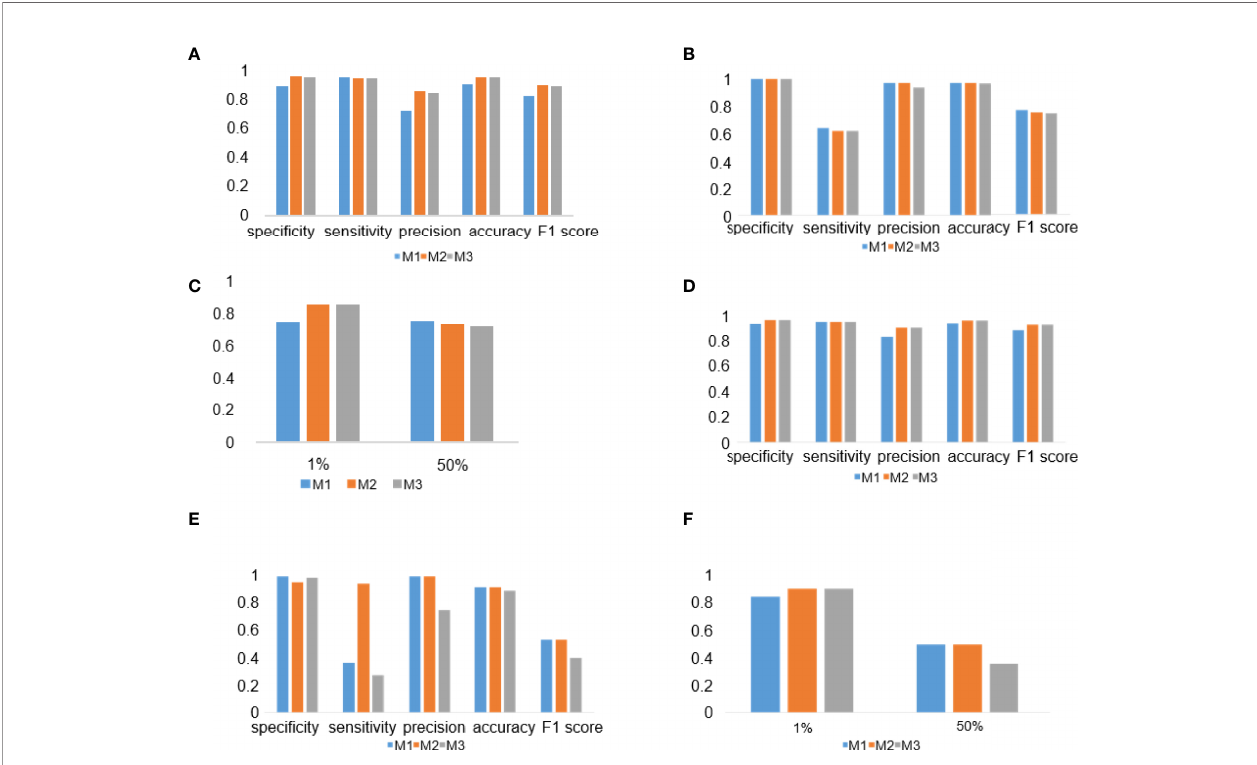
FIGURE 4 | Deep learning (DL) model performance evaluation in the PD-L1 (22C3) and PD-L1 (SP263) assays. (A – C) Histograms of DL model performance with PD-L1 (22C3) assay test. (D – F) Histograms of DL model performance with PD-L1 (SP263) assay test. Tumor proportion score cutoff values of 1% (A , D) and 50% (B , E) . Kappa score analysis (C , F)